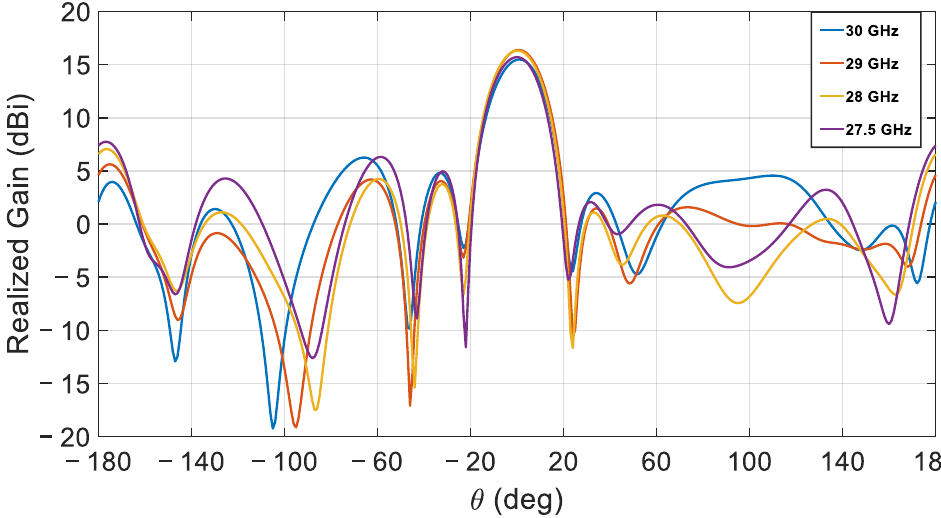
Figure 17. Simulated realized gain for the proposed CDRA array.